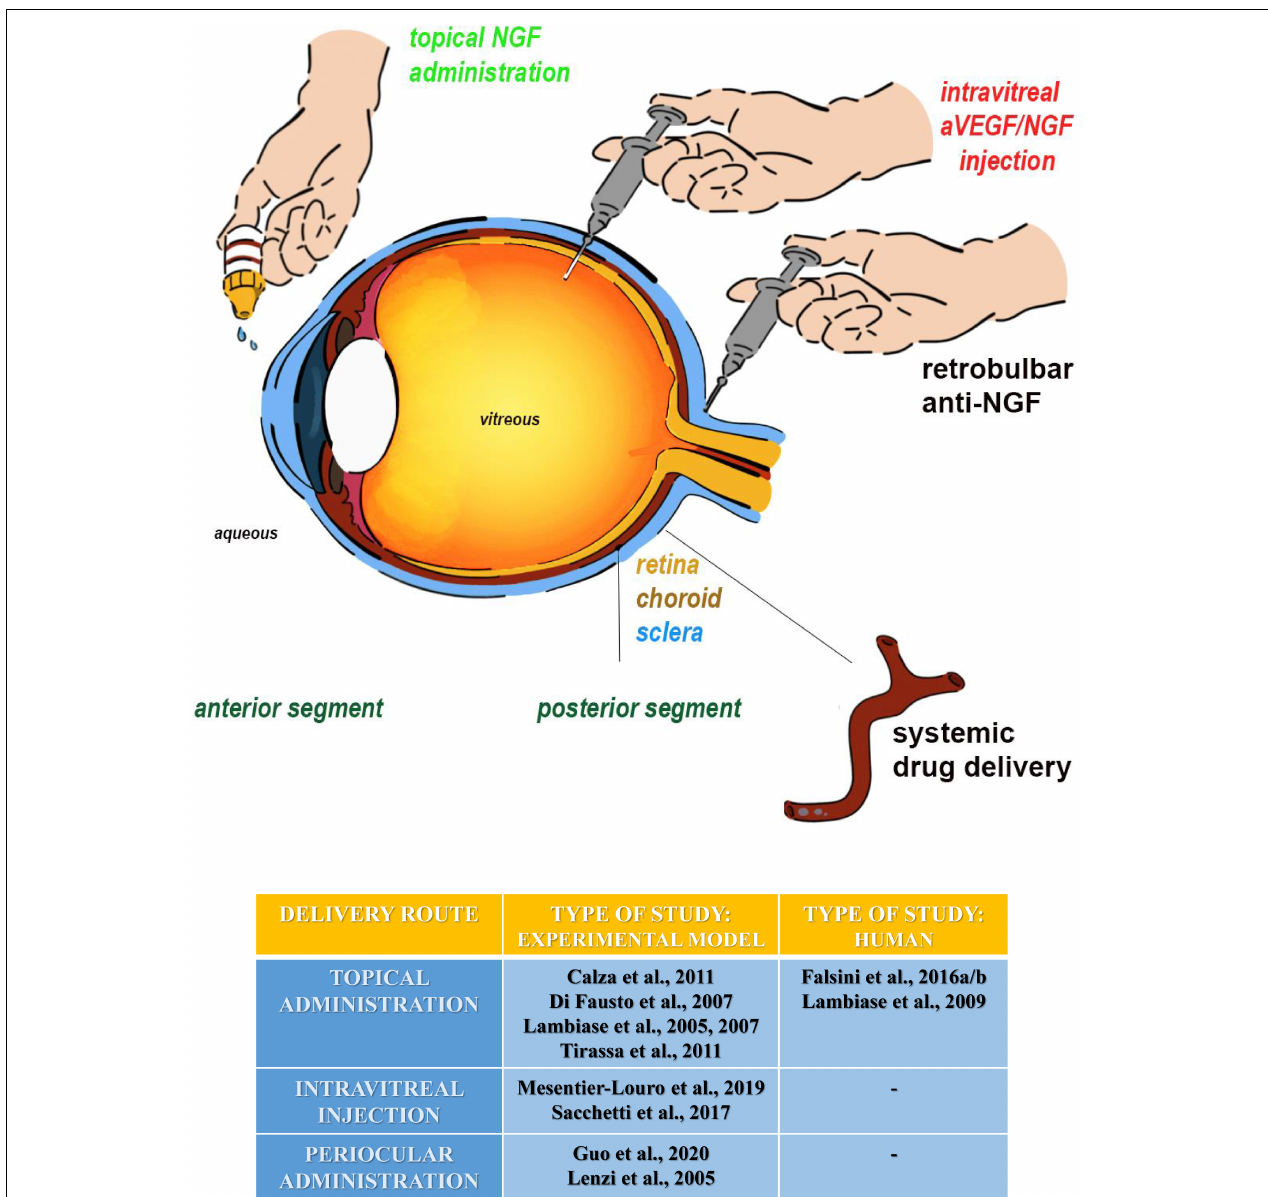
FIGURE 2 | All ocular sites tested for experimental NGF delivery are summarized as follows: (1) the topical administration (eye drop instillation and emulsion/gel application) (green labeled), (2) the intravitreal injections (ophthalmic solutions/suspentions, implants, and nanotecnology), and (3) the periocular administration (implants or injections) at the posterior segment. The periocular route includes the subconjunctival, subtenon, peribulbar, and retrobulbar sites of injection. Except for the systemic route, all the others have been tested for NGF and anti-NGF at both experimental and clinical levels. The topical administration is actually a routine procedure for specific eye disorders. Highlighted in red: our future directions on experimental animals, comprising the anti-VEGF/NGF combined intravitreal injection or the use of NGF nanoparticles layered in the vitreal chamber. The table summarizes the different routes of NGF administration in the eye, in an experimental model and human